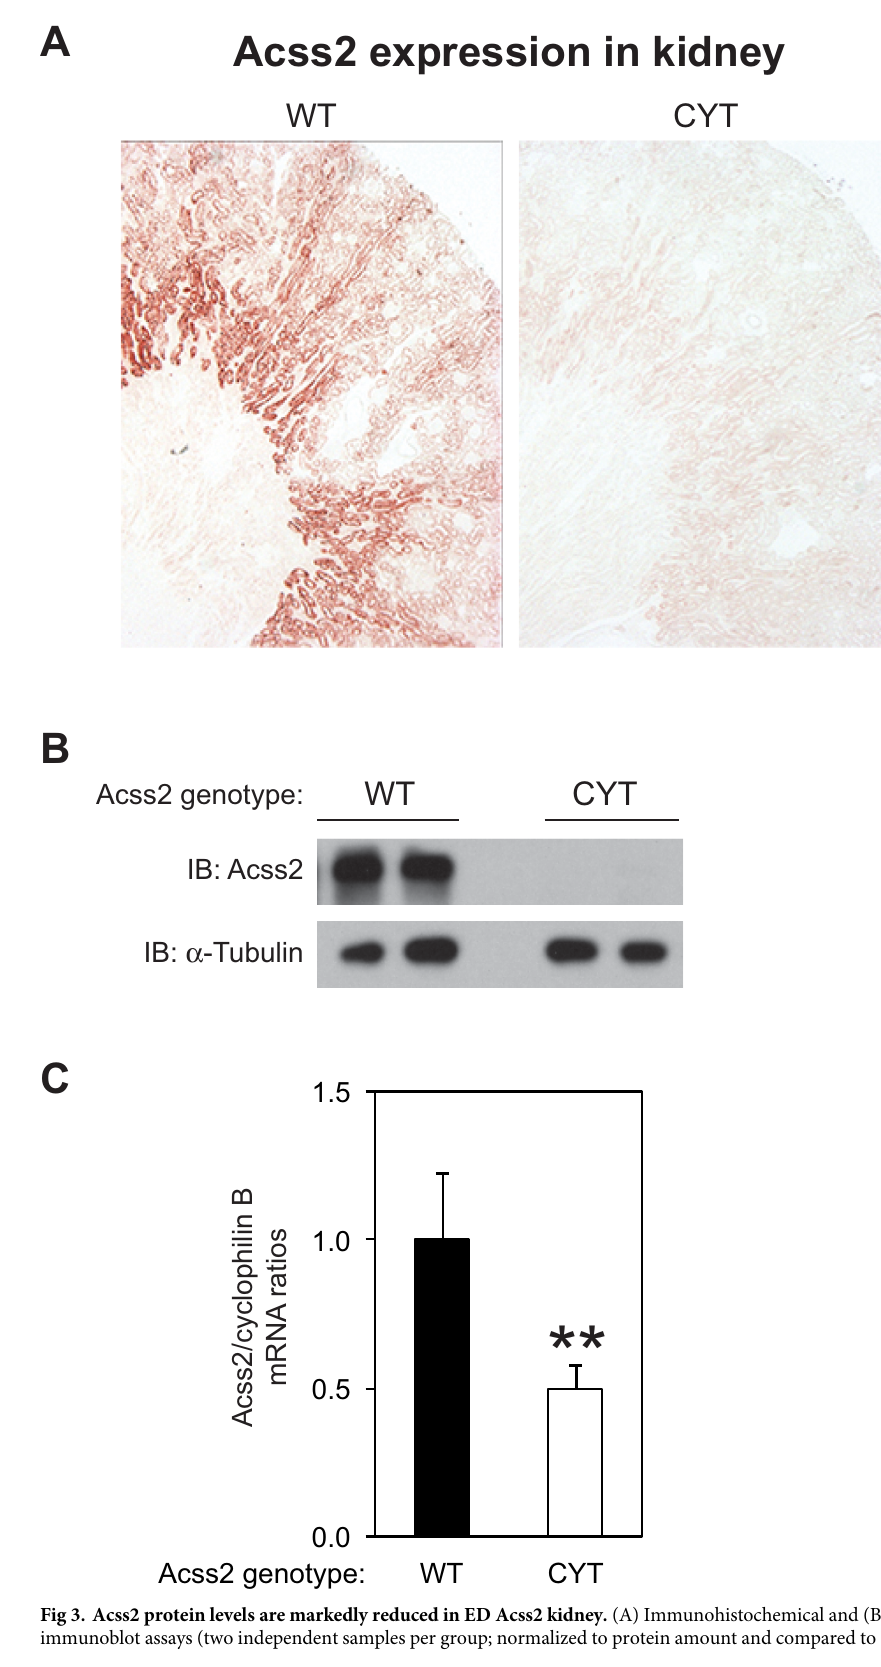
PLOS ONE | https://doi.org/10.1371/journal.pone.0225105 November14,